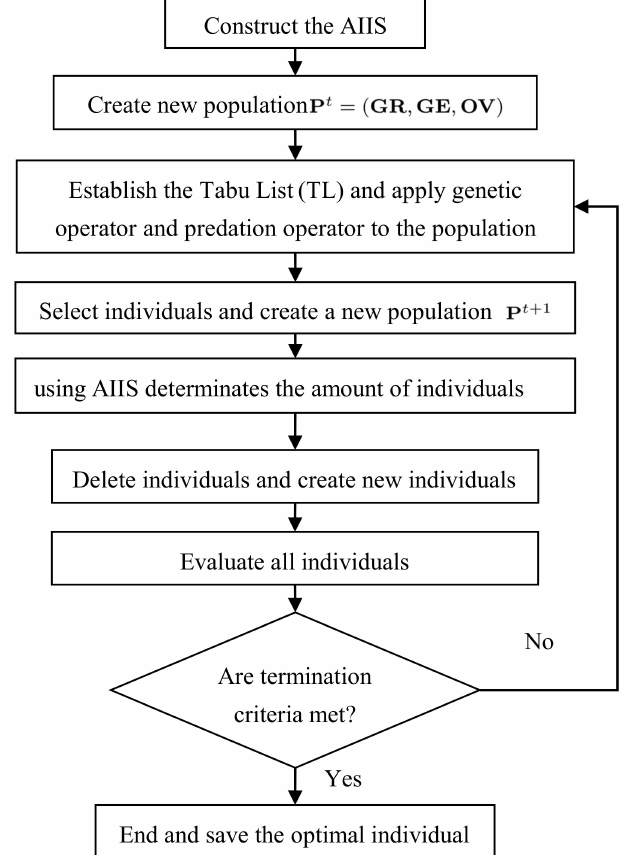
Figure 2. Flow chart of the proposed